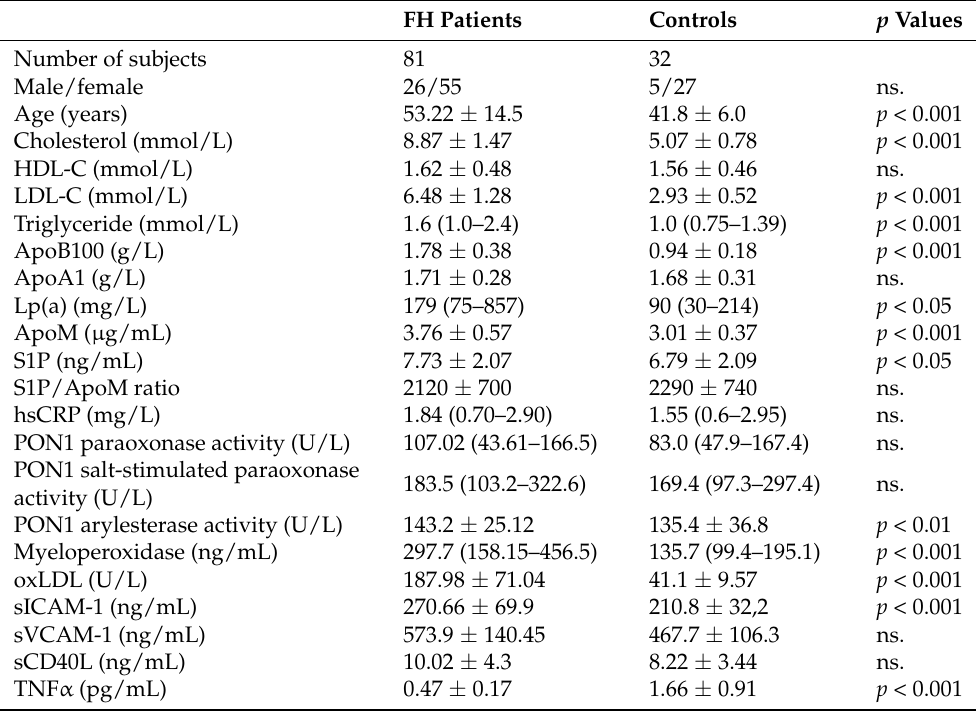
Table 1. Anthropometric and laboratory parameters of study individuals. Values are presented as mean ± standard deviation or median (lower quartile, upper quartile).